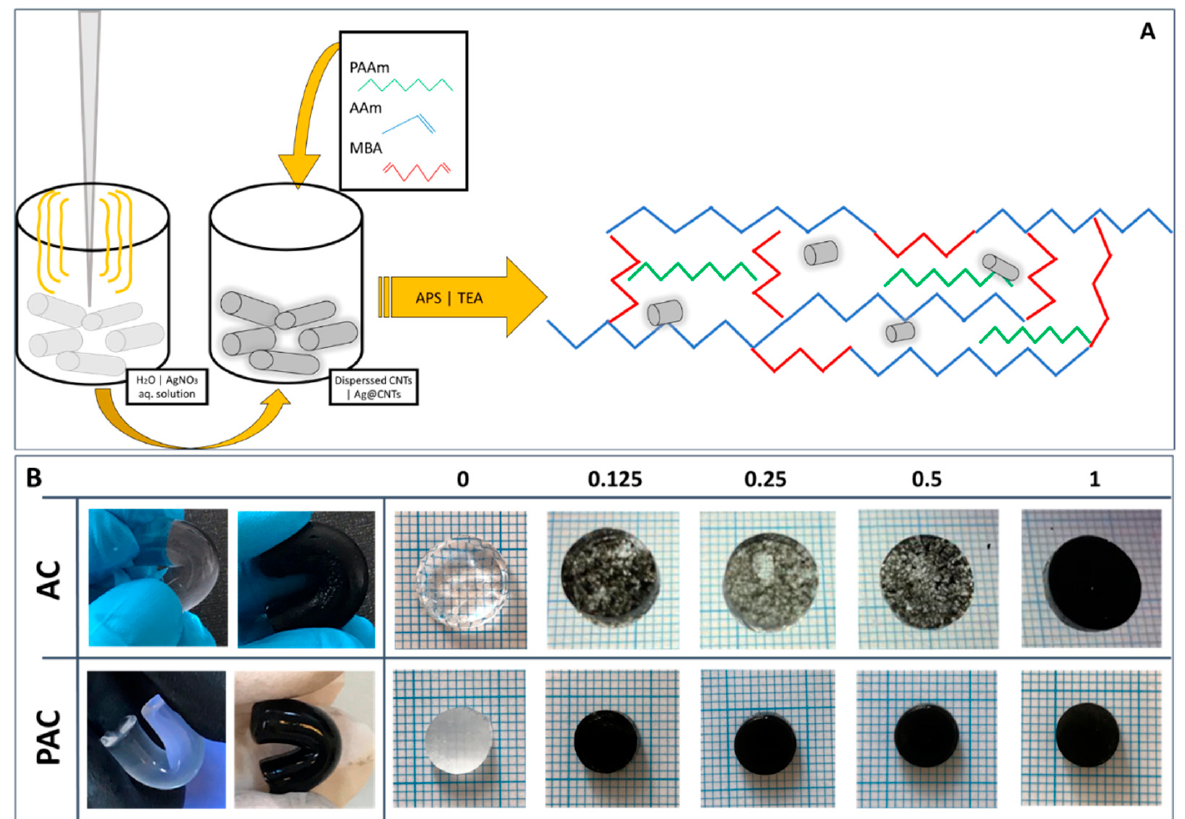
Figure 1. Panel ( A ): schematical depiction of the synthesis process of the polyacrylamide-based hydrogels reinforced with Ag-decorated CNTs; Panel ( B ): digital images of the obtained hydrogels at hydration equilibrium.